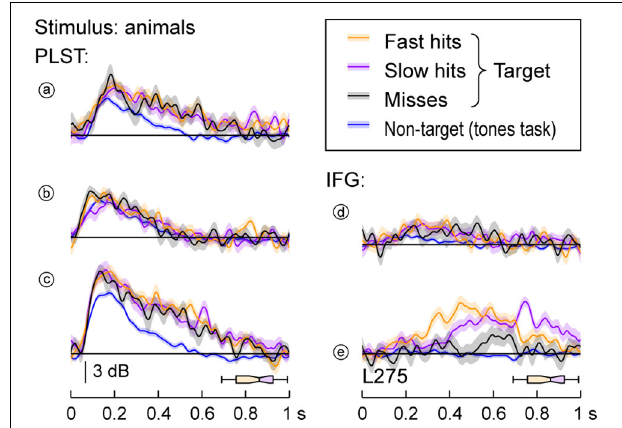
FIGURE 6 | High gamma responses to speech stimuli and the subject’s behavioral performance. Data recorded from sites (a to e) (see Figure 3A ) in response to target animal stimuli are plotted separately for trials that were associated with fast behavioral responses (17 trials; orange), slow responses (17 trials; purple), misses (11 trials; black), and non-target trials from a tone detection task (200 trials; blue). Lines and shaded areas represent mean high gamma ERBP and its standard error. Horizontal box plots denote the timing of behavioral responses to the target stimuli (medians, 10th, 25th, 75th, and 90th percentiles). See Figure 3A for location of the